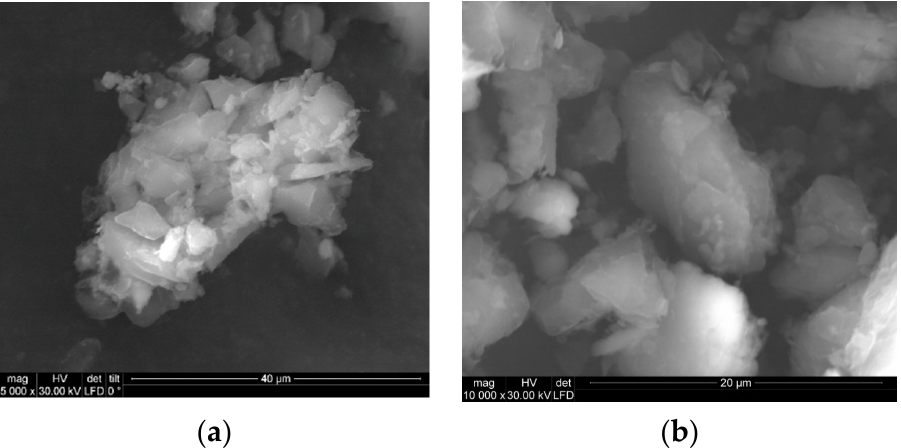
Figure 11. Examples of SEM images of hard coal particles comminuted in a hydro-jet mill at a water jet pressure of 200 MPa: ( a ) Conglomerate of comminuted superfine coal particles showing out their structures; ( b ) multi-particle view of comminuted coal.